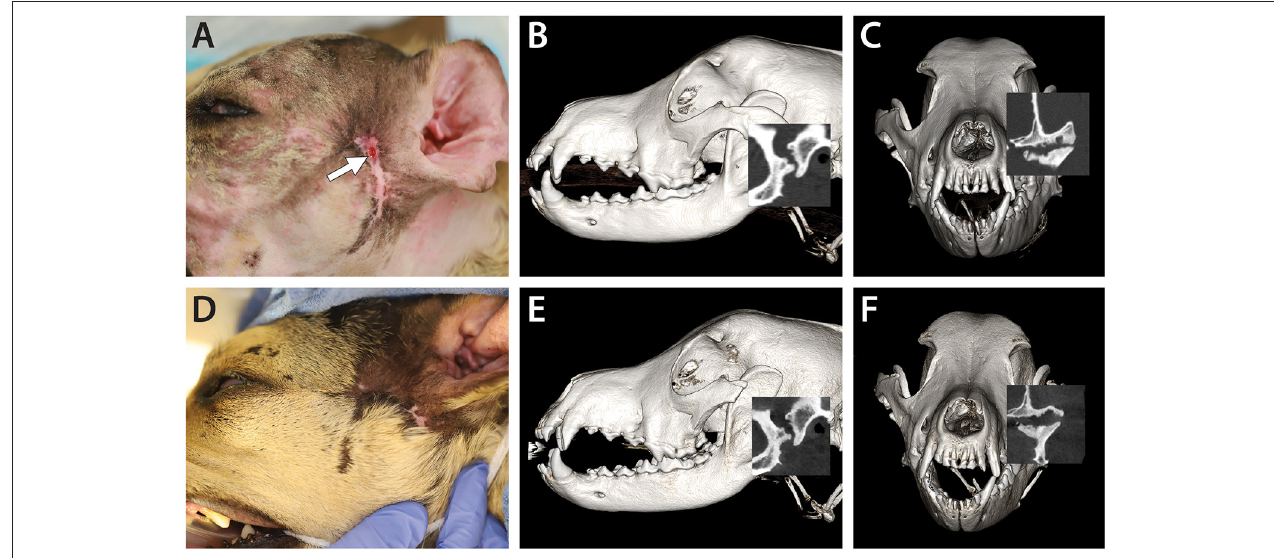
FIGURE 4 | A 3-year-old dog affected by septic arthritis of the left TMJ is described in Case 3. (A) Preoperative image demonstrating the extensive scar and the presence of a draining tract in the area of the TMJ (white arrow). (B) A lateral three-dimensional image and (C) transverse preoperative CBCT image demonstrating severe destruction of the mandibular head and the condylar process as well as erosive destruction of the articular surface of the mandibular fossa. (D) A 4-month follow-up image demonstrating the resolution of the draining tract. (E) A lateral three-dimensional image and (F) a transverse CBCT image at the 4-month follow-up demonstrating static to slightly improved features of the left TMJ.